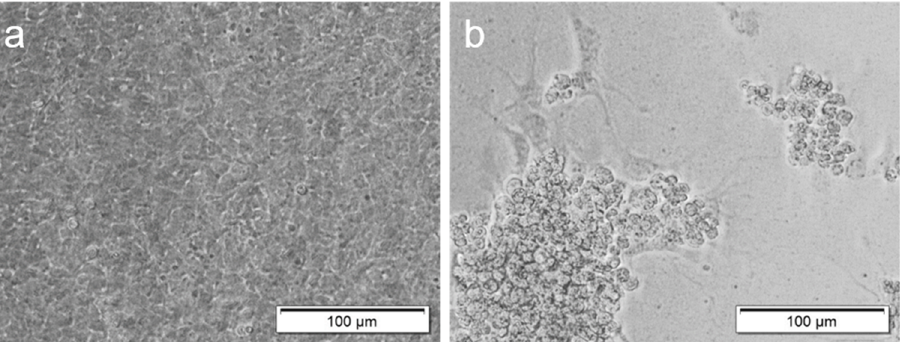
Figure 2. Cytopathic effects (CPEs) in fathead minnow (FHM) cells inoculated with goldfish chinook salmon bafinivirus Cefas-W054 at 7 days post-inoculation incubated at 20 °C. ( a ) FHM control cells. ( b ) FHM inoculated cells. CPEs consisted of detached cells (plaques) and rounded pyknotic and clumped cells.